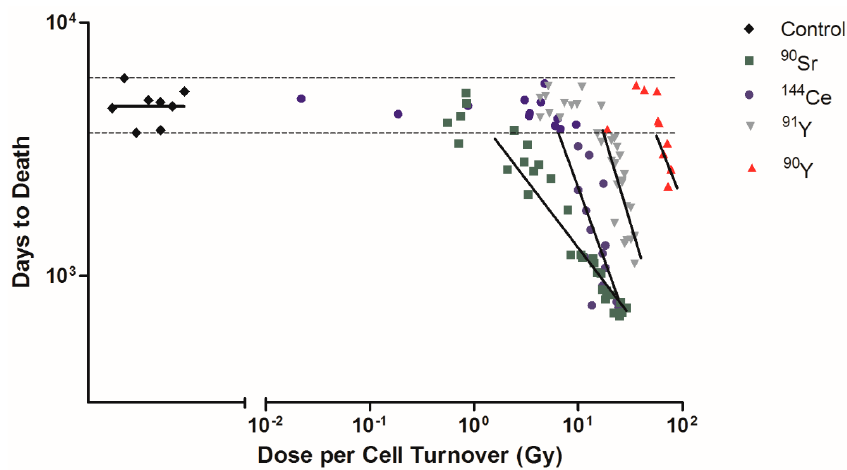
Figure 3. Dose per cell turnover was related to only the Beagle dogs that died due to lung cancer. Dose per cell turnover for 90 Sr, 144 Ce, 91 Y, and 90 Y in fused aluminosilicate particles was calculated as dose per cell turnover. Transformed dose per cell turnover were plotted against days to death following inhalation of particles for only the dogs that died due to lung cancer. Horizontal dotted lines indicate dogs that died due to spontaneous lung cancer that was not due to radiation exposure and were not included in linear regression analysis. Lines represent linear regression analysis of each radionuclide, where fit difference ranged from − 0.54 to − 1.38 (control was not significantly different from 0).